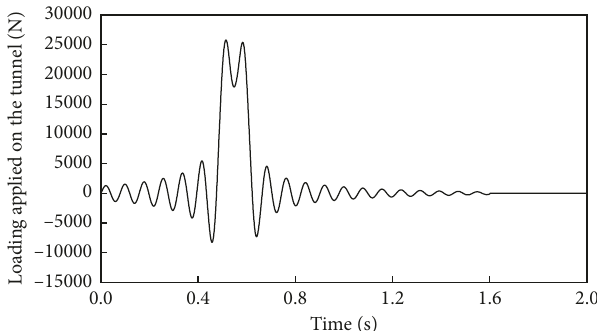
Figure 6: Vertical load applied on the tunnel shell.